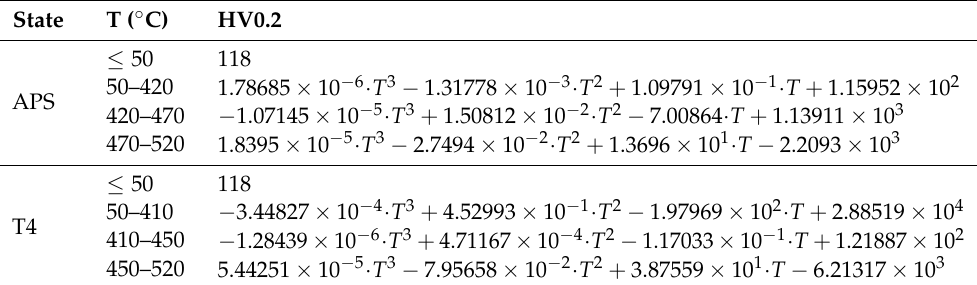
Table 5. Polynomials obtained by the fitting of micro-hardness results measured on specimens in APS and T4 states and corresponding to a 5 mm/s treatment speed.